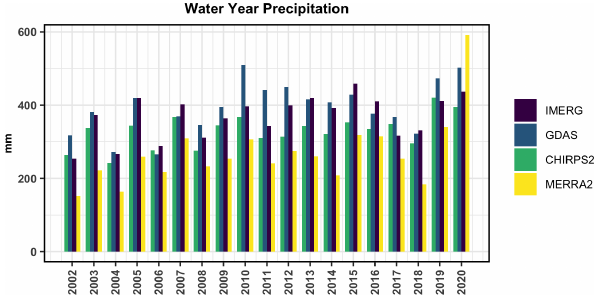
Figure 4. Afghanistan water year precipitation for CHIRPS, GDAS, IMERG Late Run, and